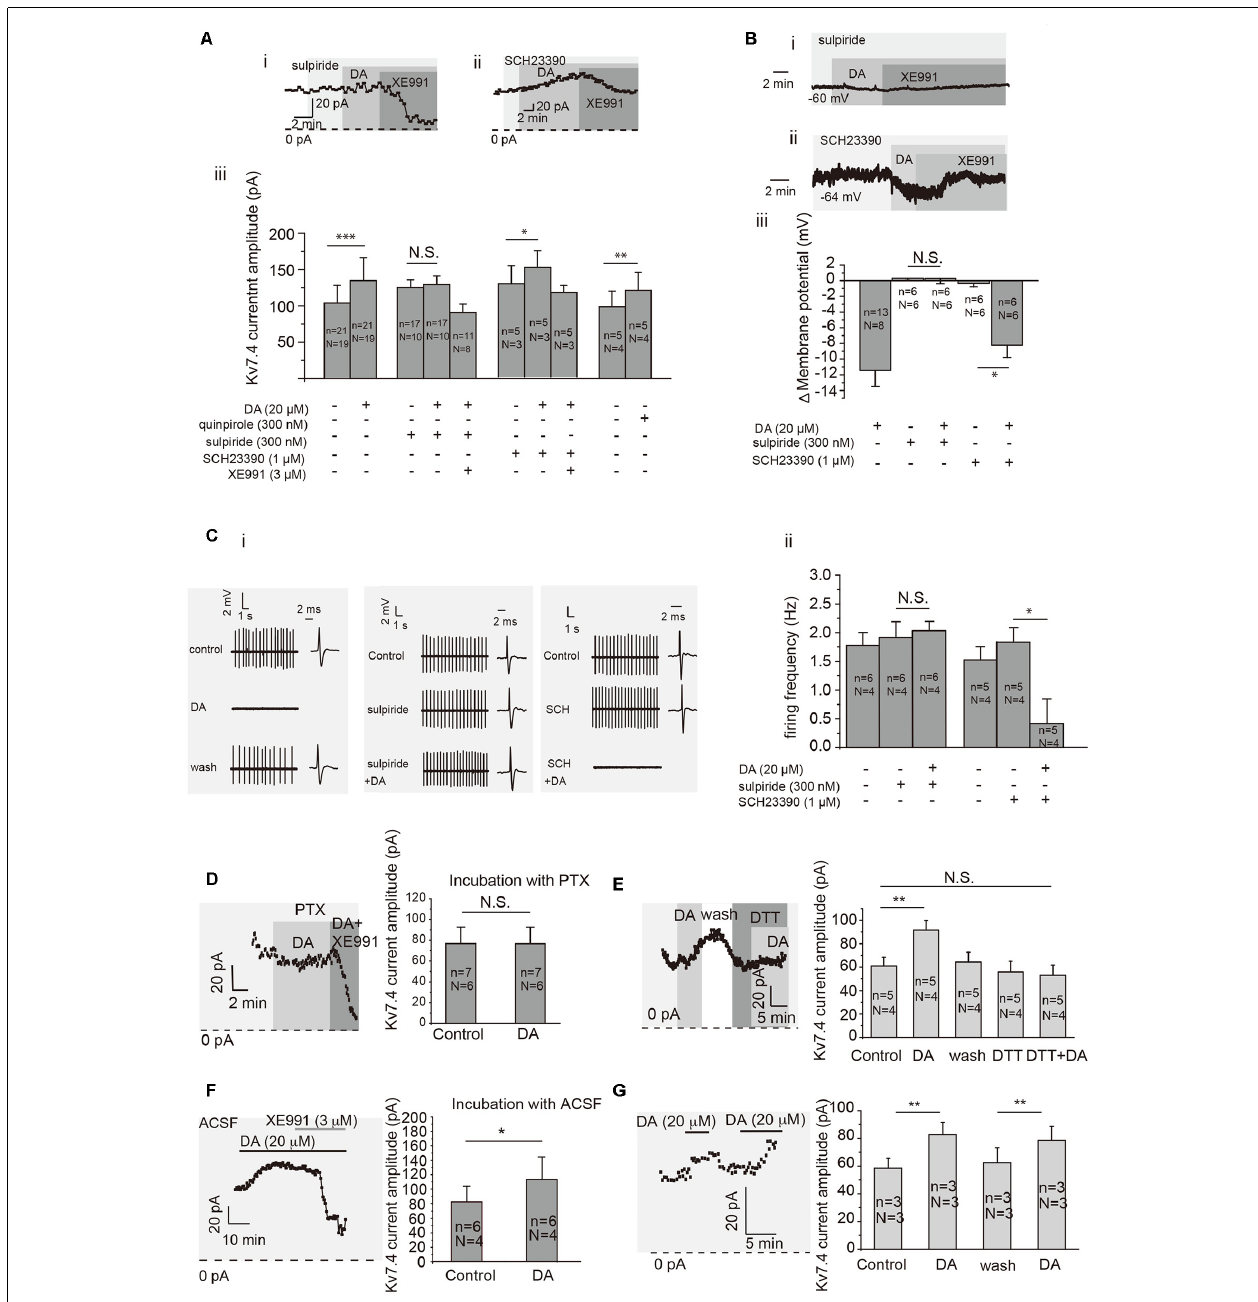
FIGURE 3 | Dopamine activates Kv7/M in VTA DA neurons through dopamine D2 receptor and related cell signaling. (Ai,ii) . Example of time-course of Kv7/M currents activated by DA in the presence of D2 receptor inhibitor sulpiride (300 nM) and D1 receptor inhibitor SCH23390 (1 µ M). (Aiii) Summarized effects of D2 receptor agonist quinpirole (300 nM), sulpiride (300 nM), SCH23390 (1 µ M) and Kv7/M channel inhibitor XE991 (3 µ M) on DA-induced activation of Kv7/M currents in VTA DA neurons. ∗∗∗ p < 0.001, ∗∗ p < 0.01, ∗ p < 0.05; N.S., not significant, paired t -test. N = number of animals; n = number of recordings. (B) Effect of sulpiride (300 nM) and SCH23390 (1 µ M; i , ii ) on the resting membrane potential of VTA DA neurons. Summarized effects of sulpiride and SCH23390 on DA-induced hyperpolarization of VTA DA neurons (iii) . ∗ p < 0.05; N.S., not significant, One-way repeated-measures ANOVA with Bonferroni test. (C) Example traces from cell-attached recordings of VTA DA neurons activated by DA in the presence of sulpiride and SCH23390 are shown in (Ci) . (Cii) Summarized effects of DA, sulpiride and SCH23390 on DA-induced inhibition of the spontaneous firing in VTA DA neurons. ∗ p < 0.05; N.S., not significant, paired t -test. (D) Pre-treating VTA DA neurons with Pertussis toxin (PTX) for 6–9 h abolished the DA-induced activation of Kv7/M channels. N.S., not significant; paired t -test. (E) Reducing agent dithiothreitol (DTT) blocked the DA-induced activation of Kv7/M channels in VTA DA neurons. ∗∗∗ p < 0.01; N.S. not significant; one-way repeated-measures ANOVA with Bonferroni test. (F) Pretreating VTA DA neurons with ACSF for 6–9 h did not affect the DA-induced activation of Kv7/M channels. ∗ p < 0.05; paired t -test. (G) Repeated application of DA induced a similar degree of Kv7/M activation. ∗∗ p < 0.01, paired t -test. N = number of animals; n = number of recordings.